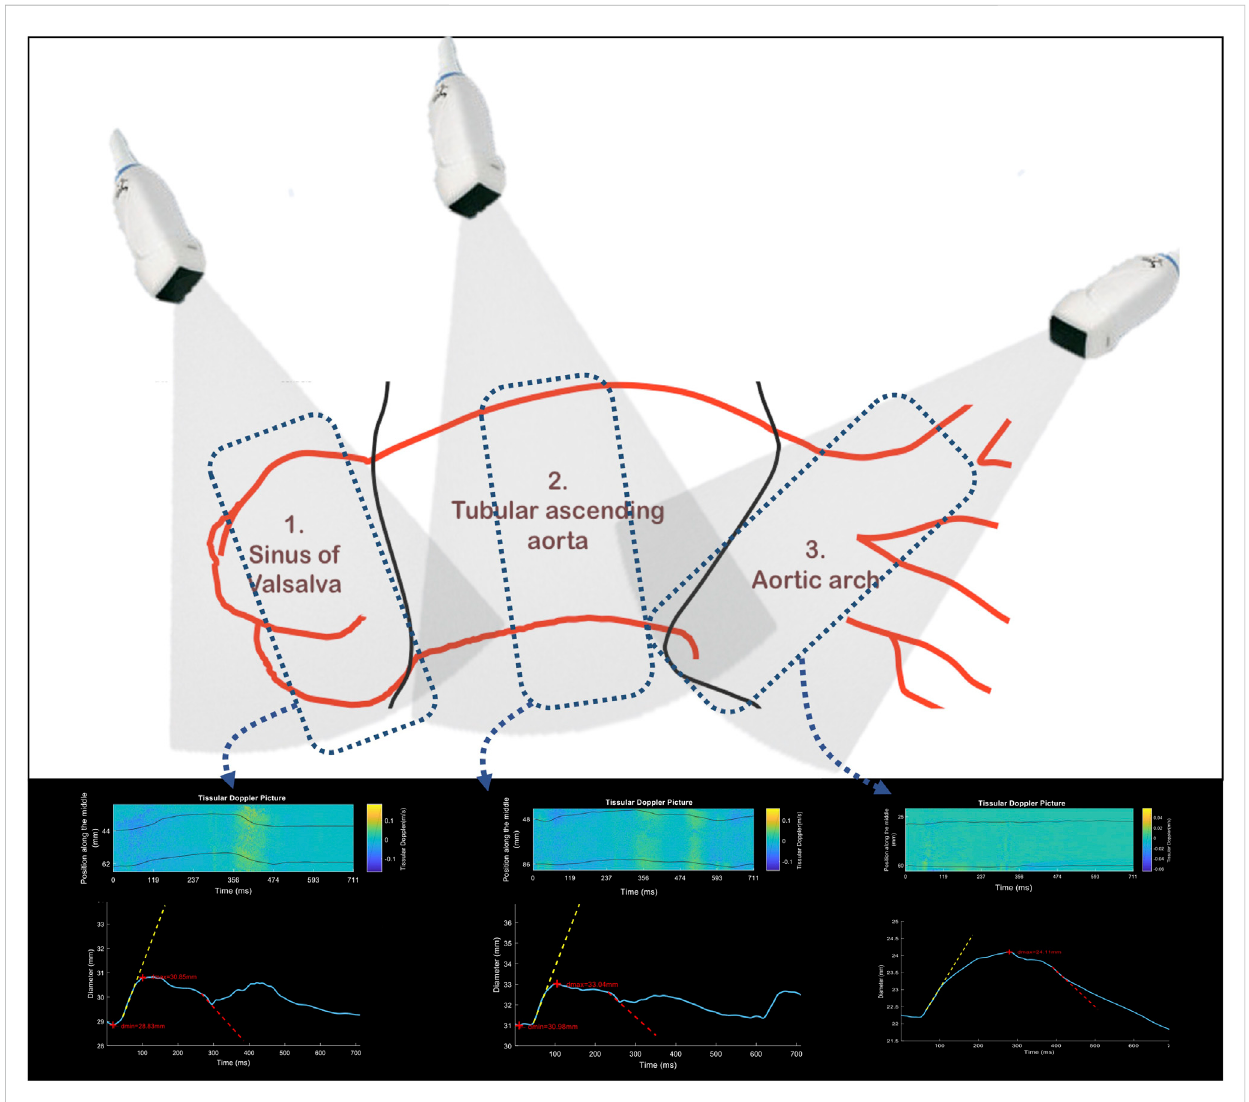
FIGURE 3 Schematicpositioningoftheechocardiographyprobe infront ofeachsegment oftheascendingthoracicaorta:sinus ofValsalva,ascendingtubular aorta, and aorticarch. At thelevel of each segment is represented an example of tissue Doppler collection,with therepresentation ofthe diameter curve (blue curve) with the maximum positive (MRSD, yellow) and maximum negative (MRDR, red) slopes.